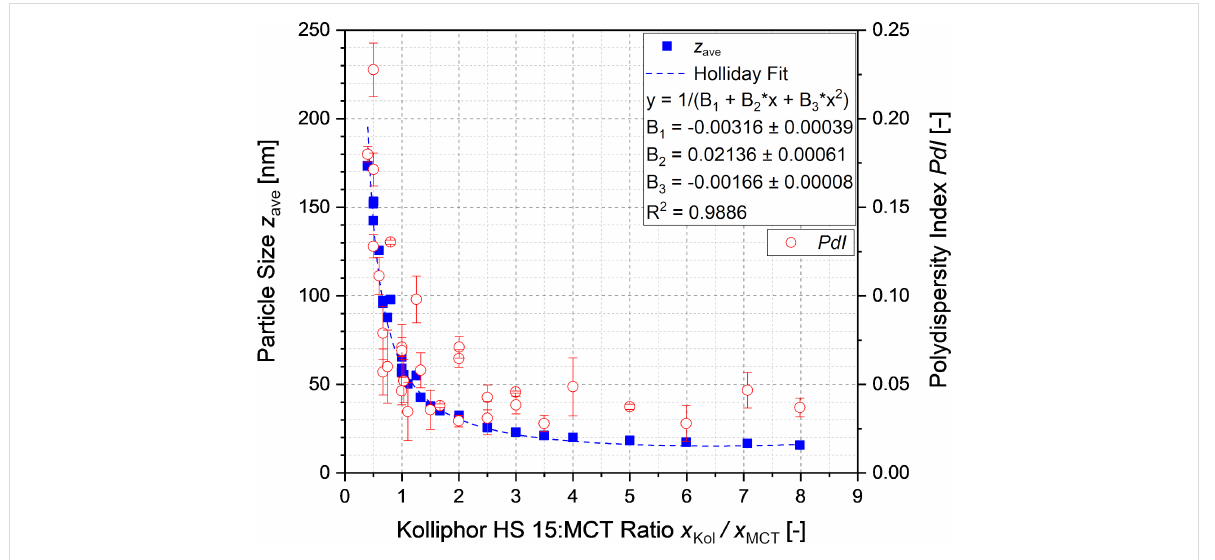
Figure 5: Particle diameters and PDI of the nanoemulsions depending on the Kolliphor HS 15:MCT ratio.